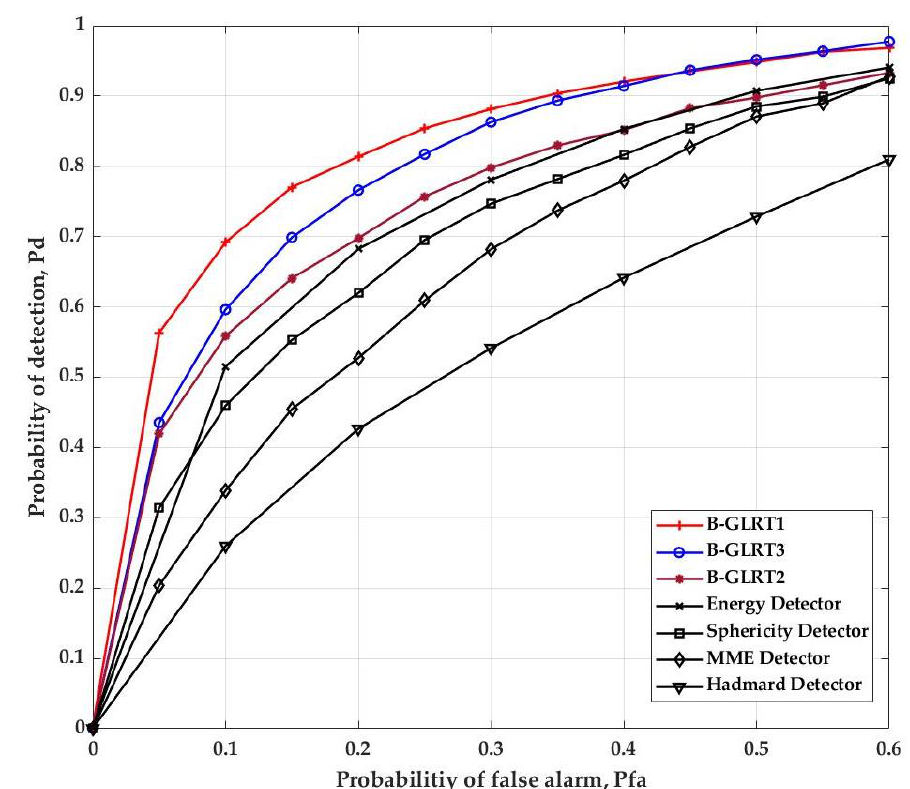
Figure 4. The ROC performance of the proposed B-GLRT where a SNR = –3 dB, N r = 3 and L = 10.